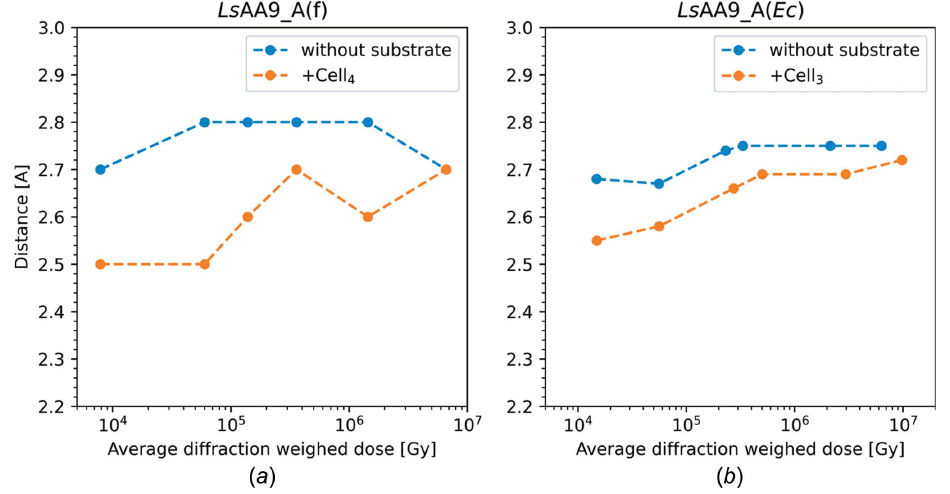
Figure 6 The measured Cu—Tyr-O distance over the Cu 2+ to Cu + transition for Ls AA9_A(f) and Ls AA9_A( Ec ). A slight increase in the distance is found over the transition and a more significant reduction in the distances for all doses is found once substrate is bound. This is further presented for the low-dose structures in Movie